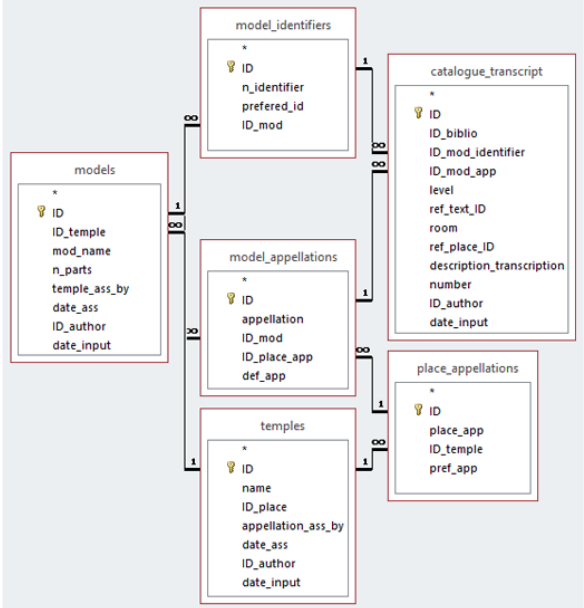
Figure 6. database relationship structure for catalogue transcripts and its connected